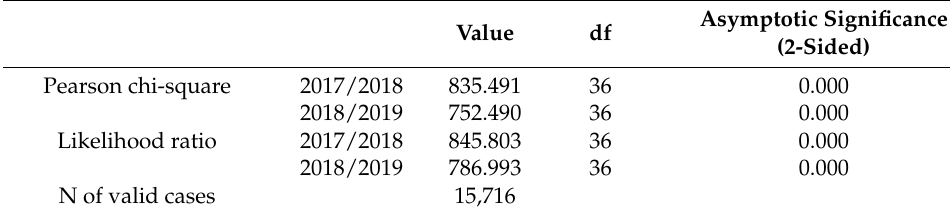
Table 3. Chi-square test (sectoral classification vs. discretionary